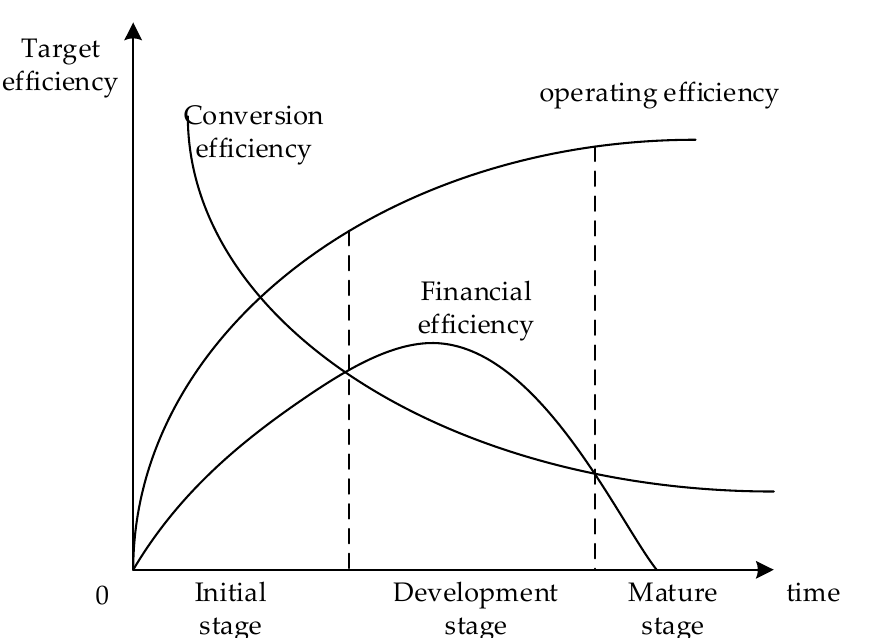
Figure 3. Analysis of the development stage of prefabricated buildings.